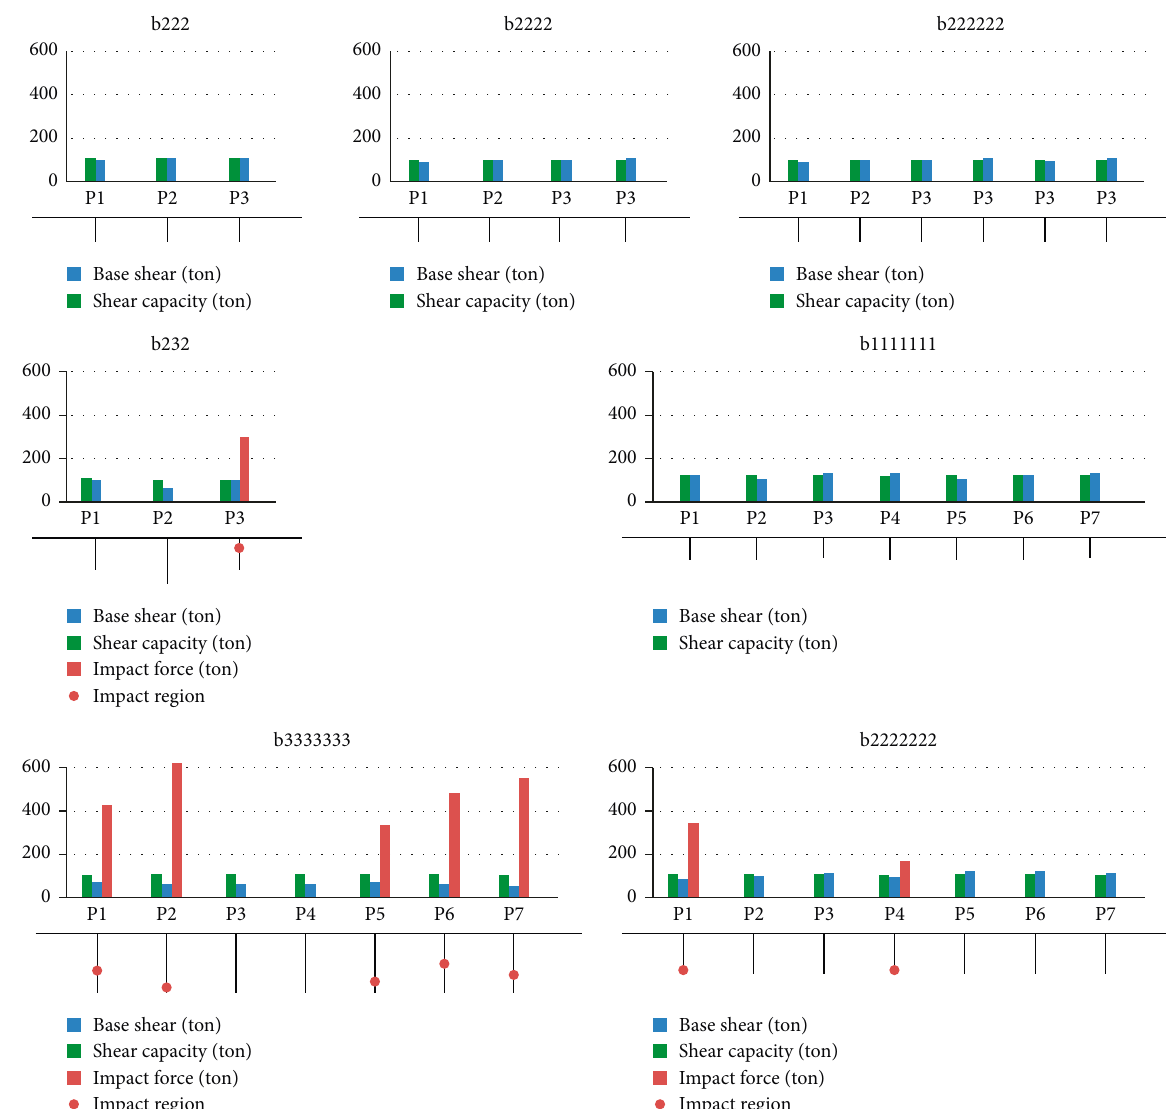
Figure 19: General information and overall view of comparing impact force with seismic base shear and the collision region in regular bridges under the artificial ground